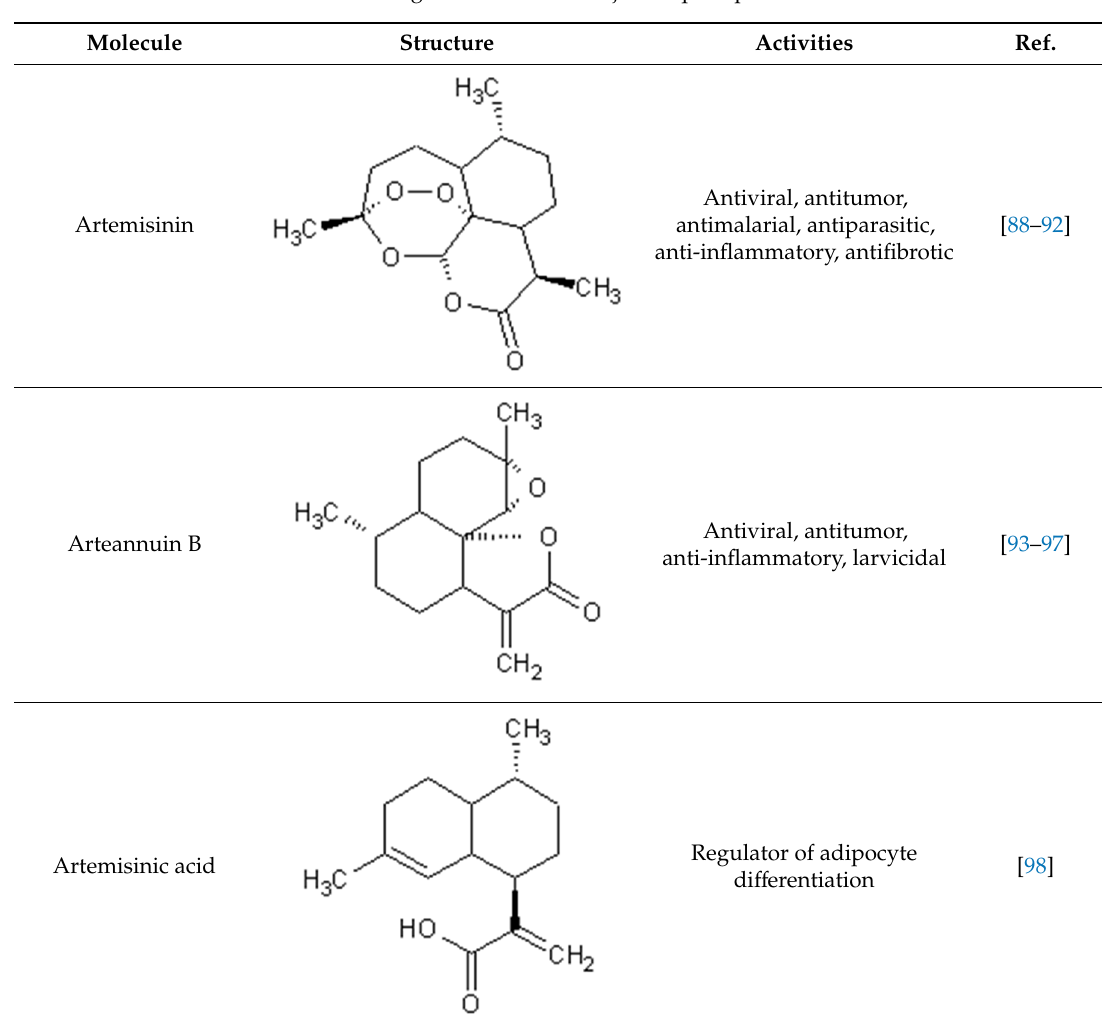
Table 2. Structure and biological activities of major sesquiterpenes of Artemisia annua .